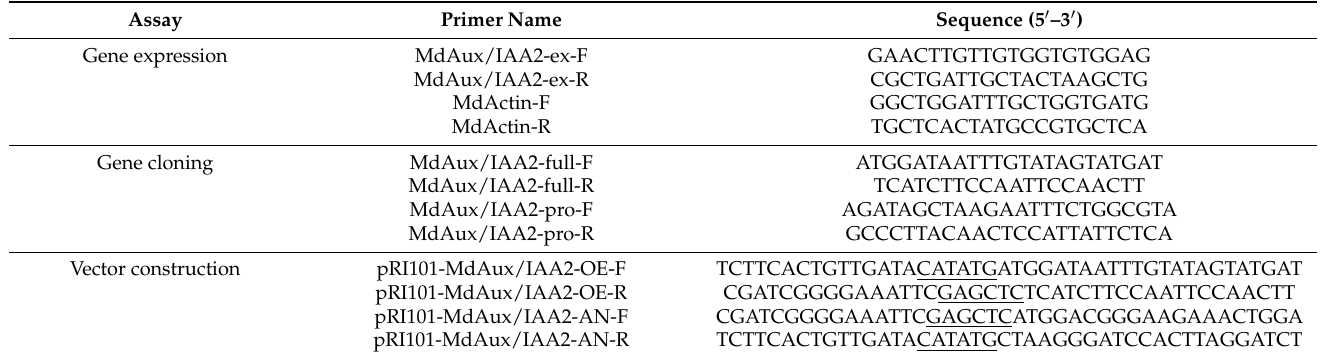
Table 4. Primers used in this study. The Nde I and Sac I sites used for vector construction are